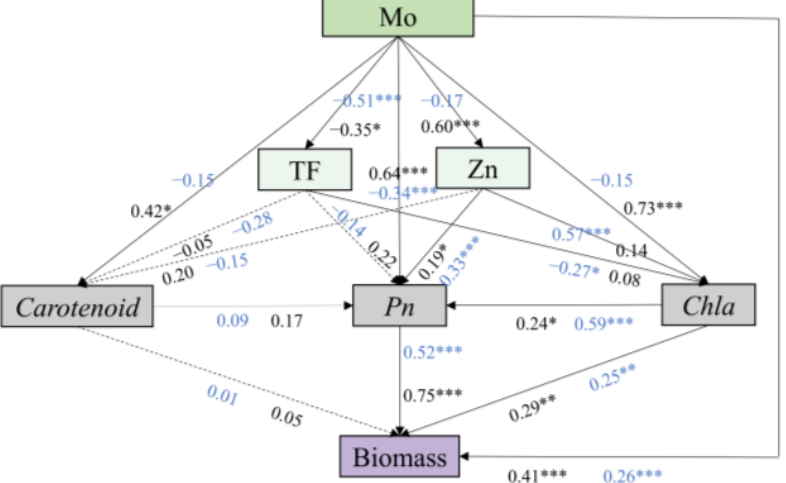
Figure 7. Structural equation model (SEM) analysis of the main pathways of AMF and Mo addition with maize physiological characteristics (Chla, Pn , and carotenoid), Mo TF, and nutrient uptake on maize biomass. Black and blue arrows represent AMF and Mo paths, respectively. Solid arrows represent significant positive or negative effects. Dashed arrows represent nonsignificant paths. Numbers near lines represent standardized path coefficients ( r ), * p < 0.05; ** p < 0.01; *** p < 0.001.